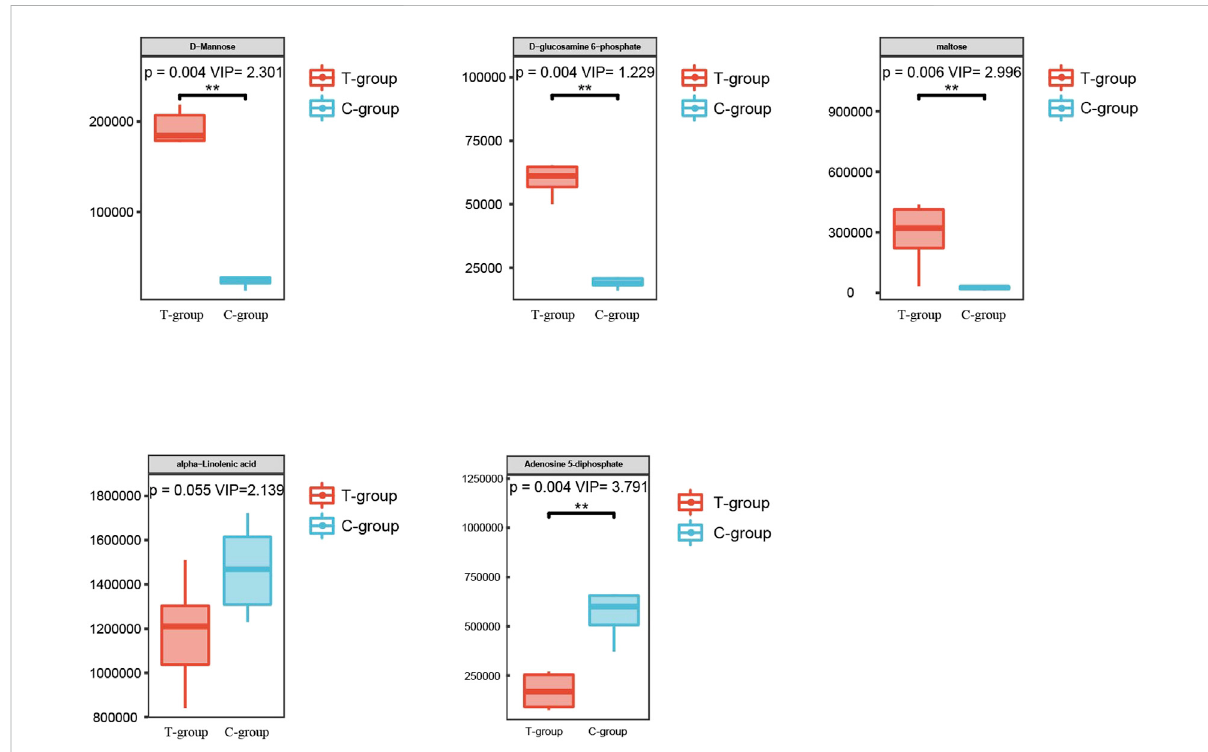
FIGURE 6 Metabolites with signi fi cant differences between the two